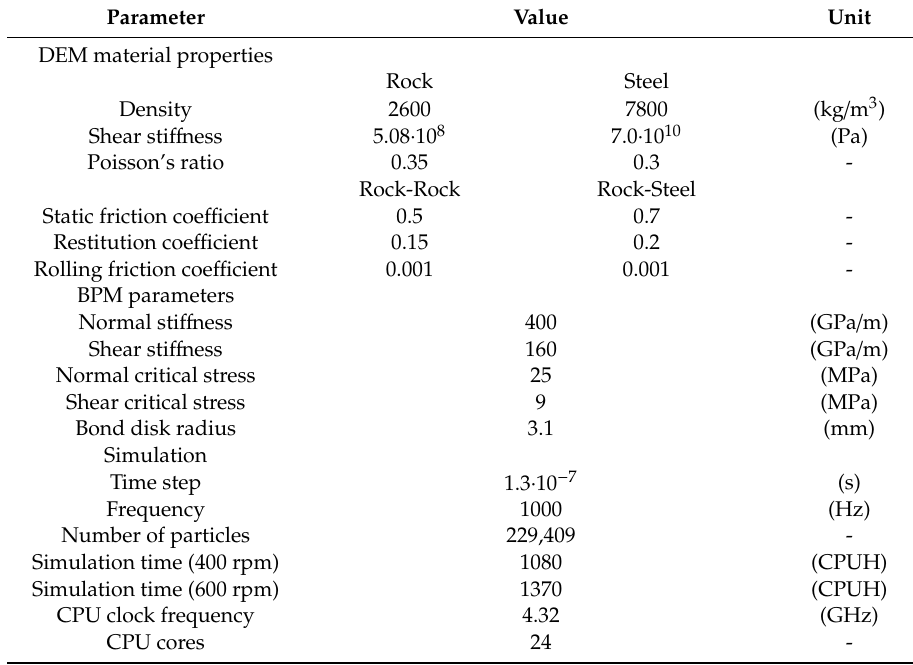
Table 4. Parameters for the EDEM